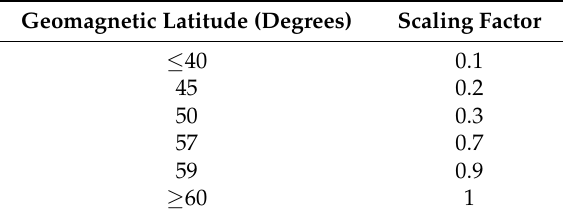
Table 2. Geomagnetic field scaling factors [20].